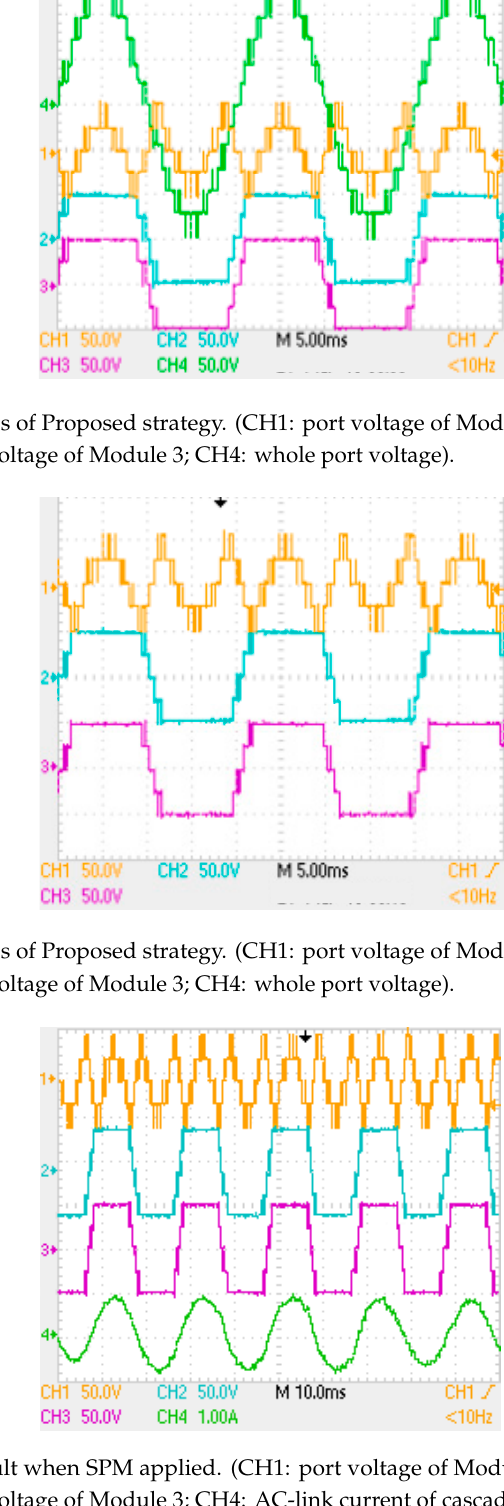
2; CH3: port voltage of Module 3; CH4: whole port voltage ).